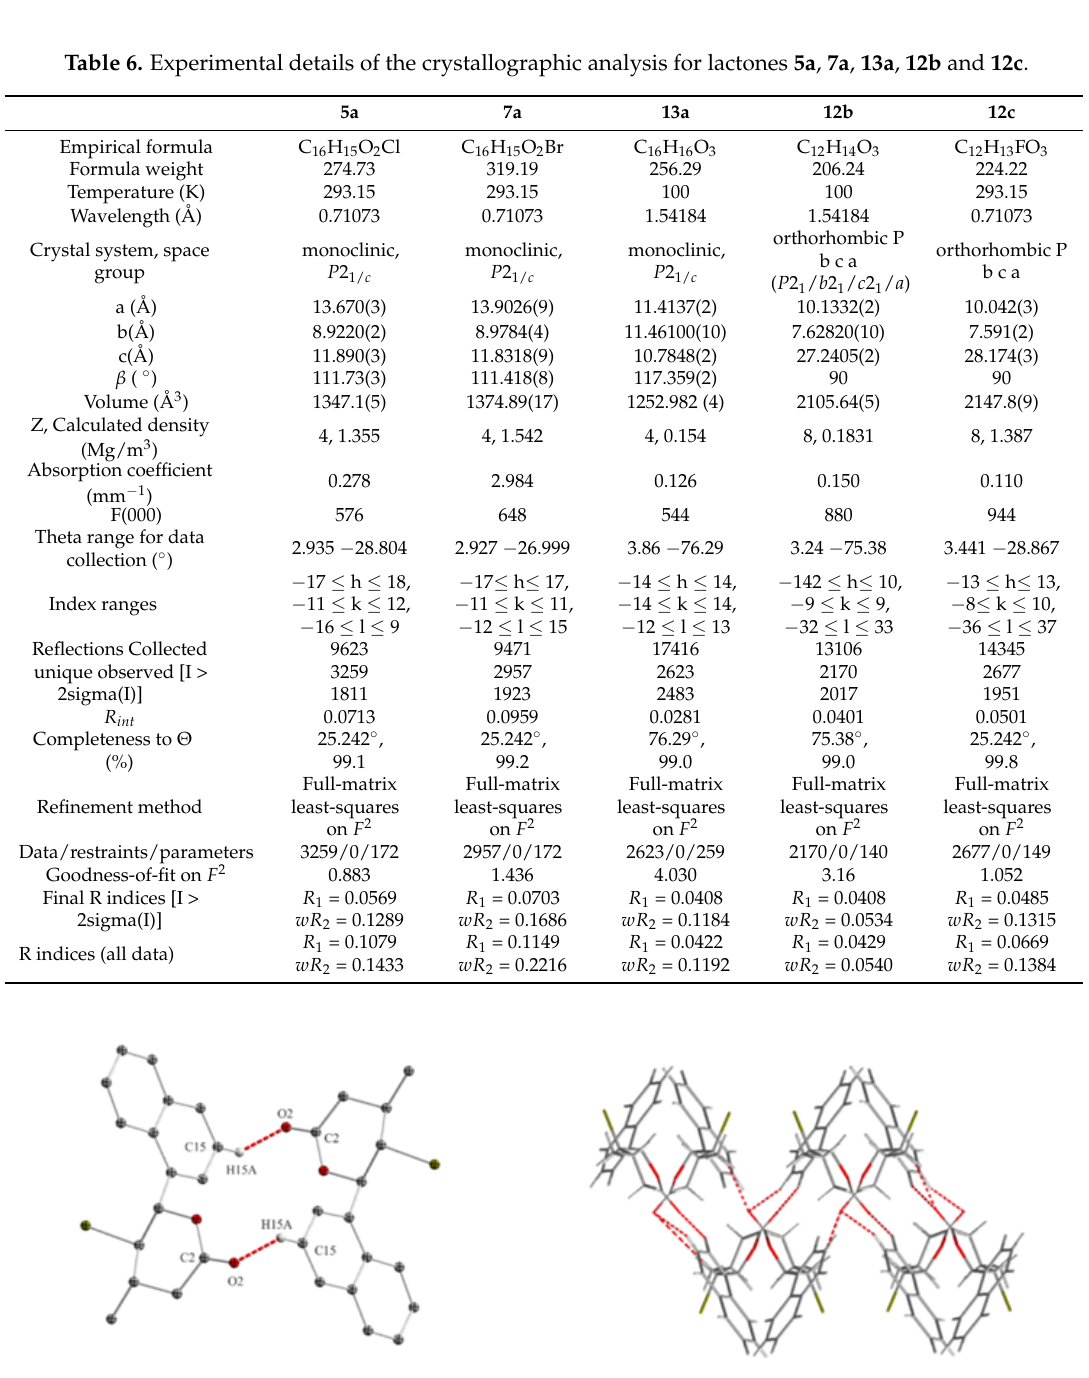
Figure 9. The arrangement of 7a in the unit cell